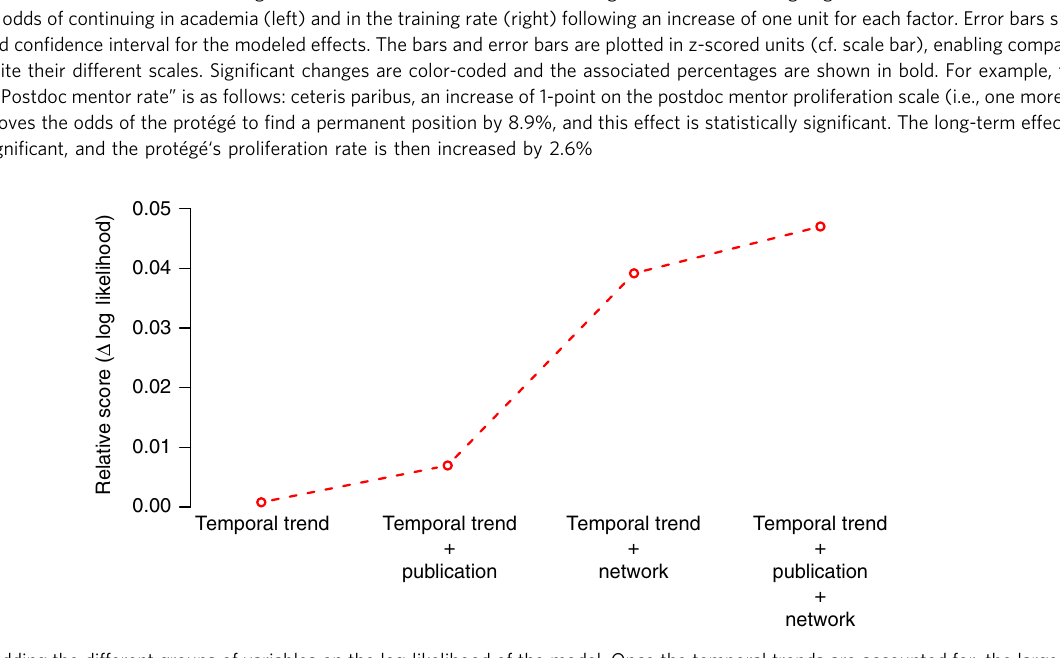
Fig. 5 Impact of adding the different groups of variables on the log-likelihood of the model. Once the temporal trends are accounted for, the largest effect corresponds to the inclusion of mentor network features (training rate and academic